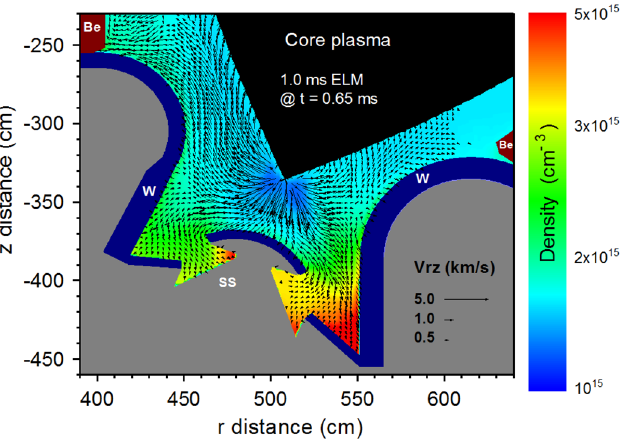
Figure 3. Secondary plasma density and velocity evolution at t = 0.65 ms during the 1.0 ms ELM. The images were prepared using OriginPro V2020.